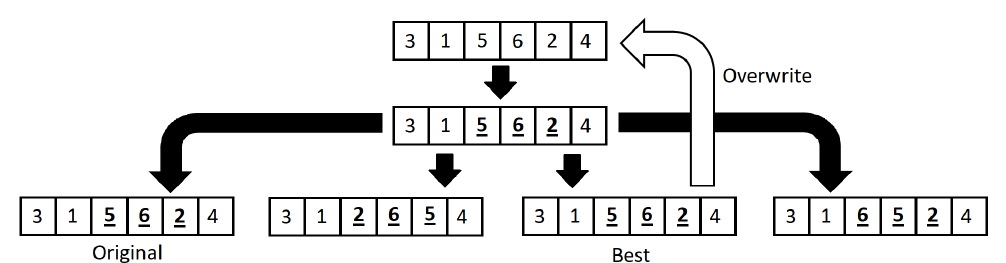
Figure 6. Bacterial mutation. The values of the selected segment in each specimen are underlined. The white arrow represents that the original specimen is overwritten by the best